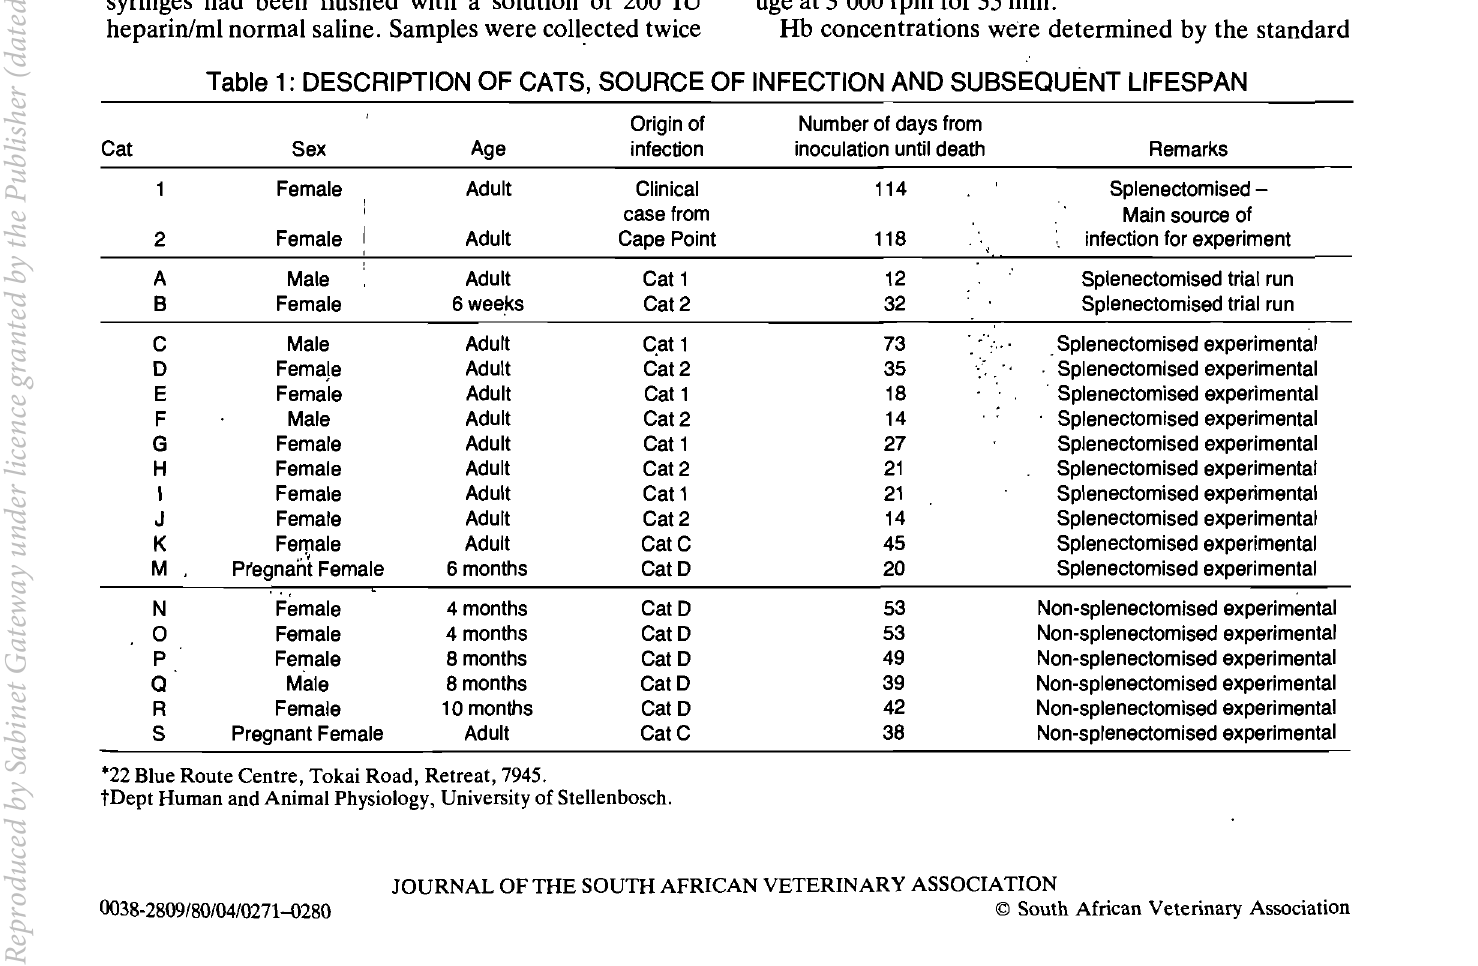
Table 1: DESCRIPTION OF CATS, SOURCE OF INFECTION AND SUBSEQUENT LIFESPAN Origin